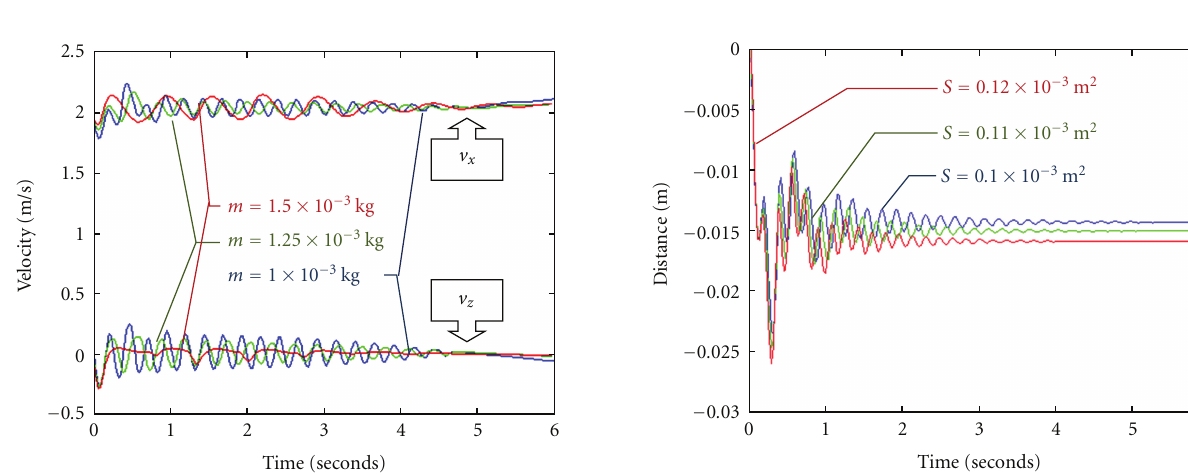
Figure 11: Dragonfly gliding down—changing the wing area. Distance versus time.